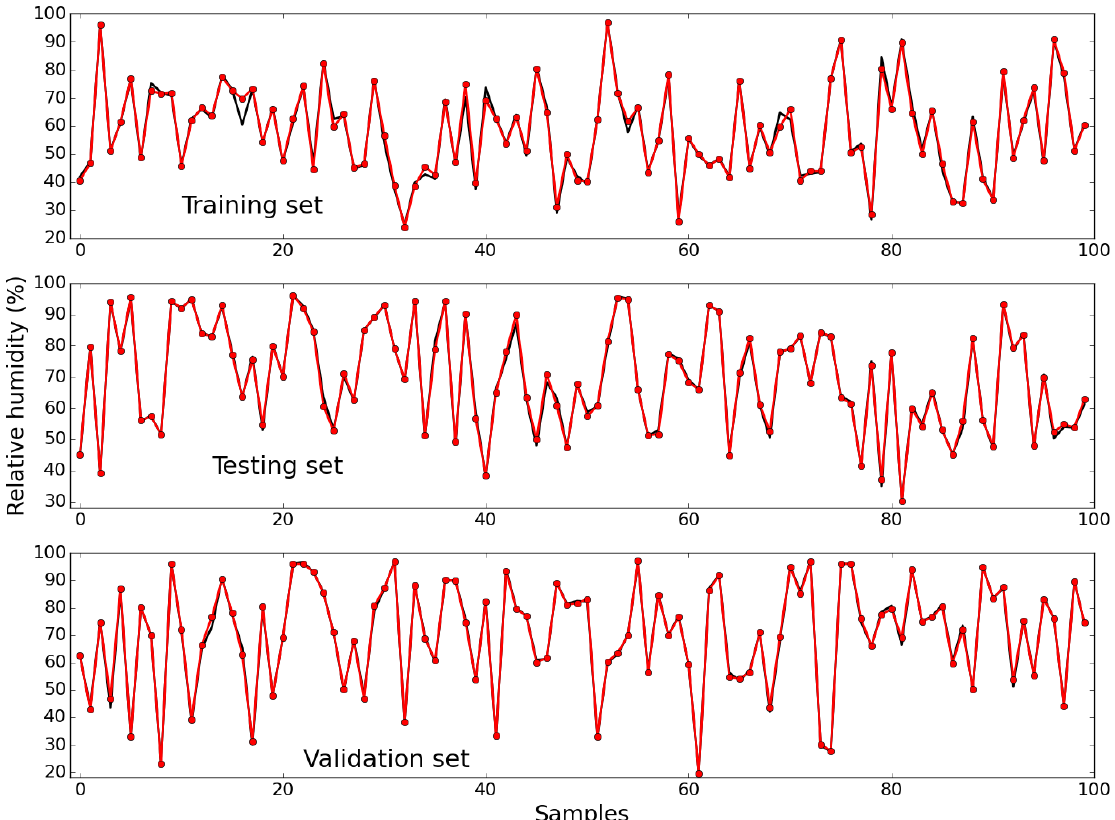
Figure 9. Measured (black) and estimated (red) values of relative humidity, for the first 100 samples of the training ( Top ); testing ( Middle ); and validation ( Bottom ) data sets.